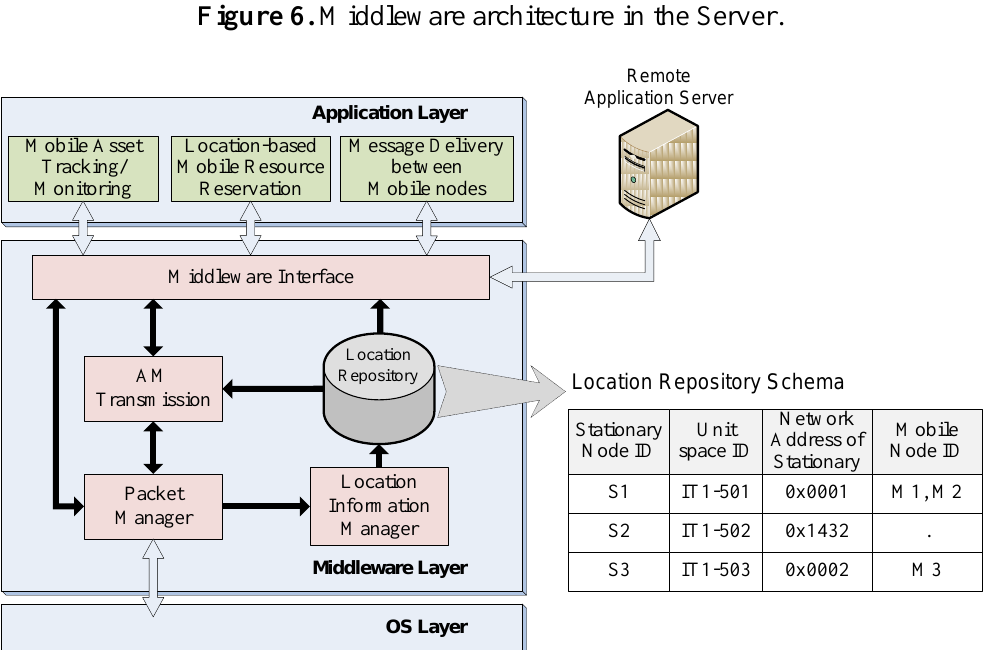
Figure 6. Middleware architecture in the